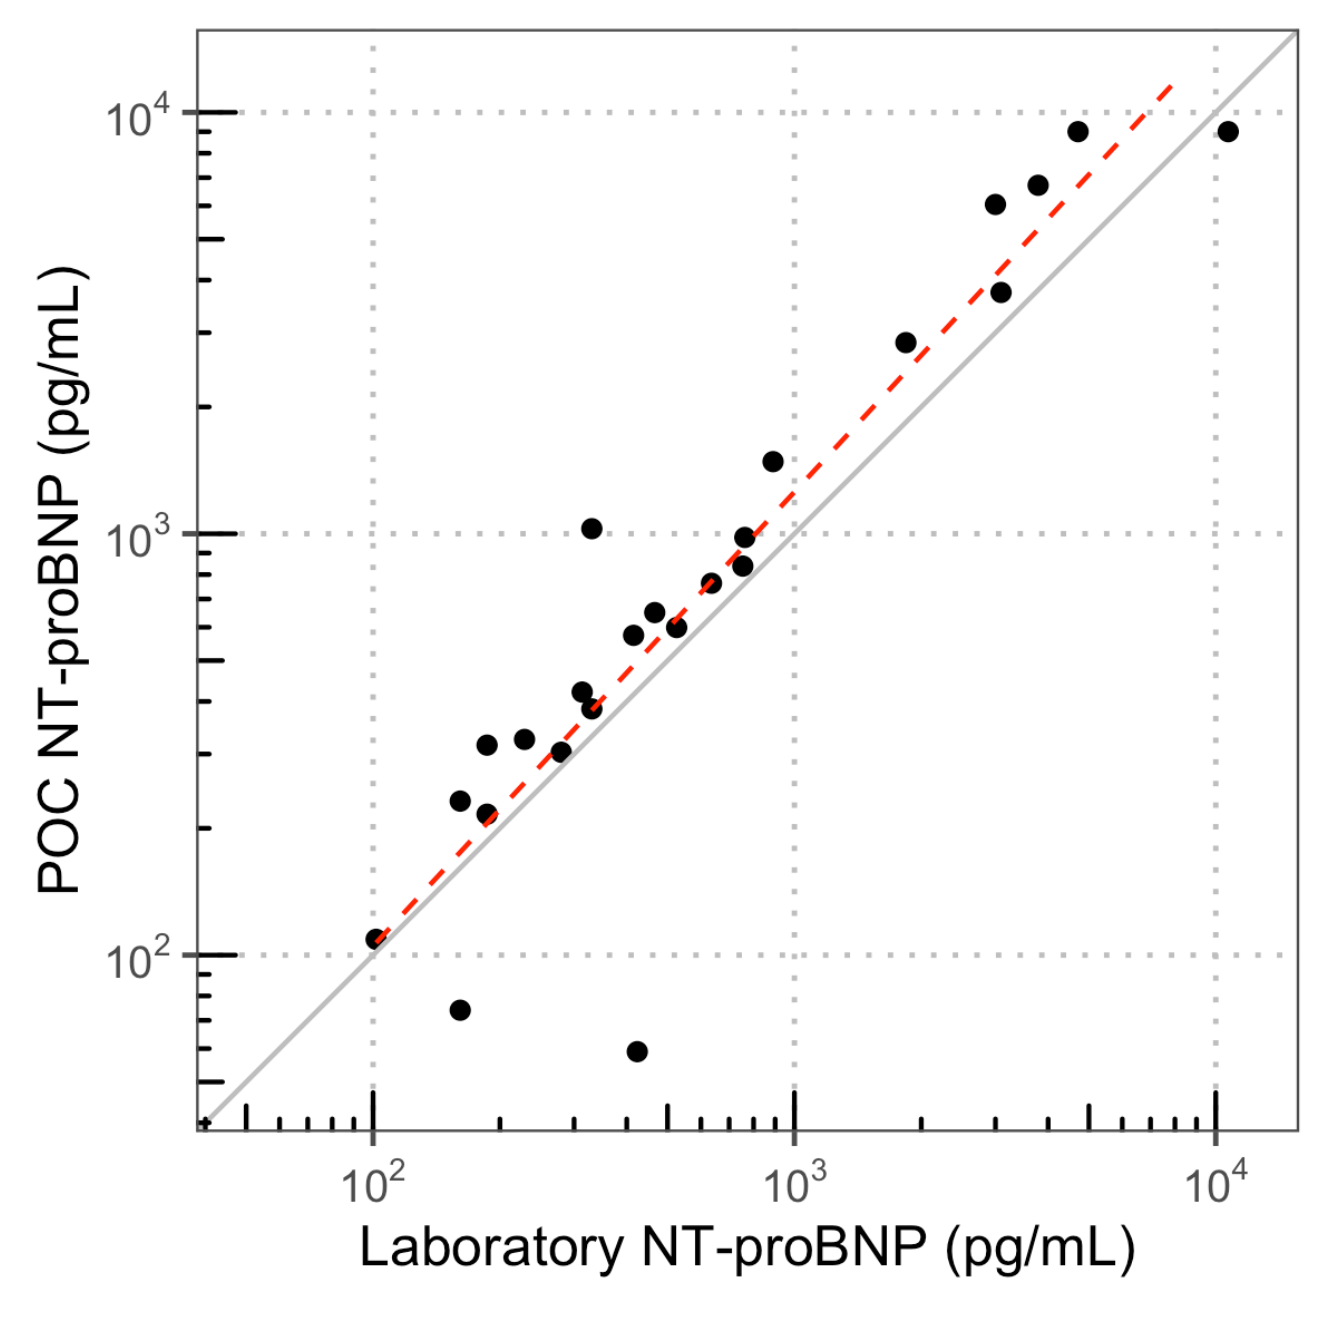
Figure 3 Scatter plot and Passing and Bablock regression of log- transformed point- of- care (POC) and laboratory N- terminal B- type natriuretic peptide (NT- proBNP) showing close correlation (R 2 = 0.9). Intercept: –0.3 (95% confidence interval (CI) = –1.6–1.0). Slope: 1.1 (95% CI =